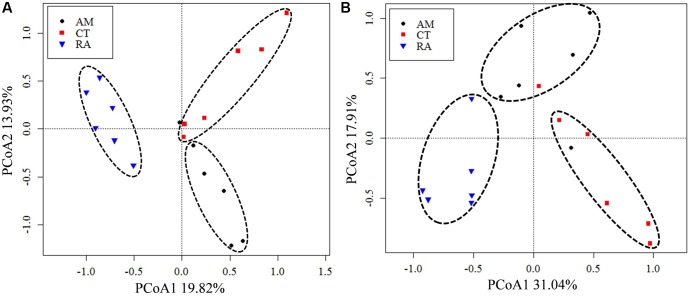
Principal coordinates analysis (PCoA) of total 16S rRNA (A) and nifH
(B) gene communities based on high-throughput sequencing data. The percentage of variation explained by each axis is shown. RA, R. apiculata. AM, A. marina. CT, C. tagal.